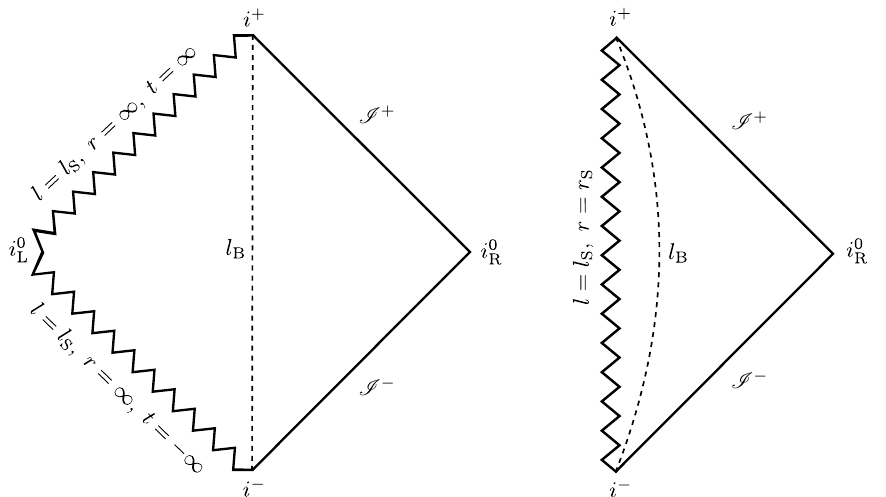
Figure 2. ( Left figure ): Penrose diagram of the singular wormhole solution in the Polyakov ap- proximation. The vertical dashed line l B represents the location of the wormhole neck. To its right, the asymptotically flat portion of spacetime is depicted. The left side of the diagram shows the internal past and future null singularities, which are located at finite proper distance from the neck l B l S . The point i 0 is singular as well and is reached in finite proper time by spacelike geodesics. L − ( Right figure ): Penrose diagram of the singular wormhole solution in the s -wave approximation. The dashed curve represents the position of the wormhole neck. The singularity is timelike and located at finite radial distance from the neck, constituting a naked